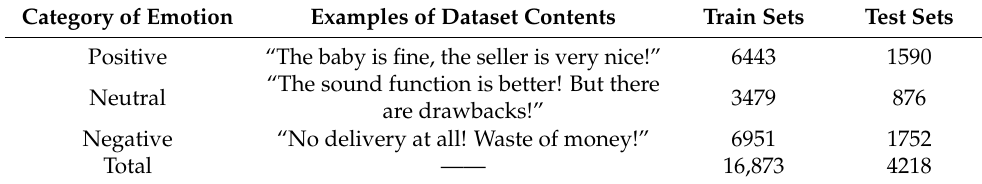
Table 1. Introduction to the dataset.